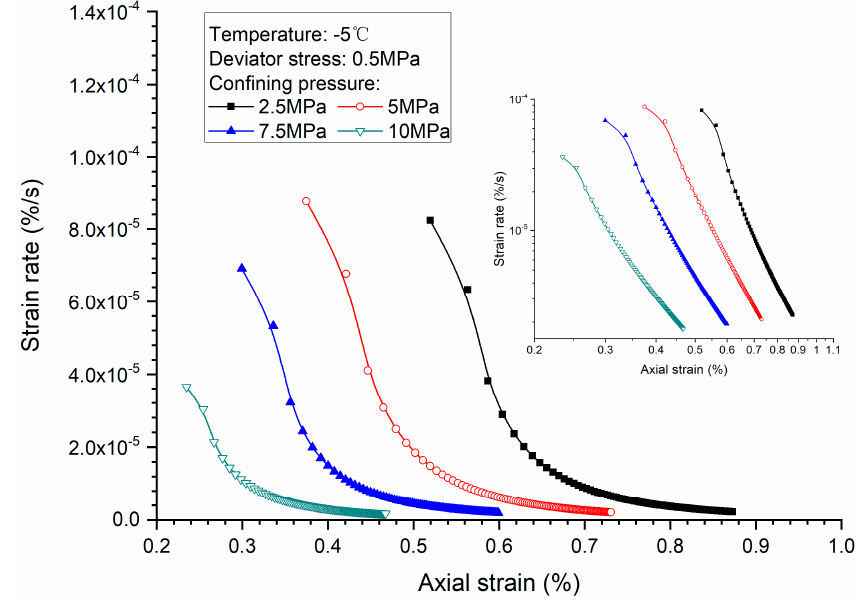
Figure 10. Creep strain rate versus axial strain for methane hydrate-bearing frozen specimens under various confining pressure.